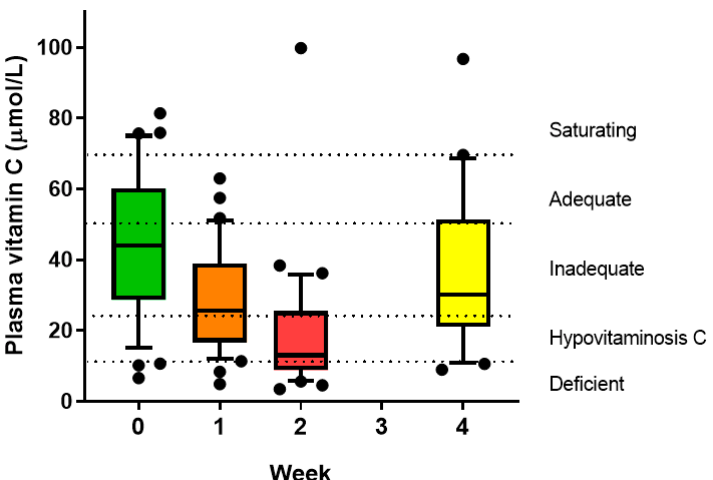
Figure 1. Vitamin C status of individuals undergoing myeloablative conditioning and hematopoietic stem cell transplantation (HSCT). Box plots show median with 25th and 75th percentiles as boundaries, and whiskers are the 10th and 90th percentiles, with symbols indicating outlying data points. Vitamin C category cut-offs are indicated by dotted lines. The mean values for weeks 1 and 2 were significantly lower than baseline ( p ≤ 0.001).